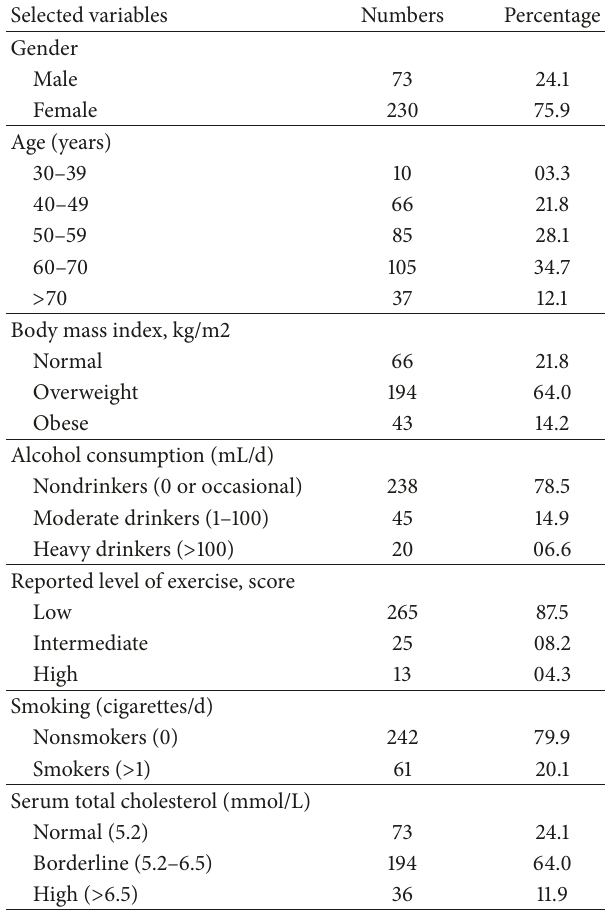
Table 1: Selected demographic and risk factors among hyperten-